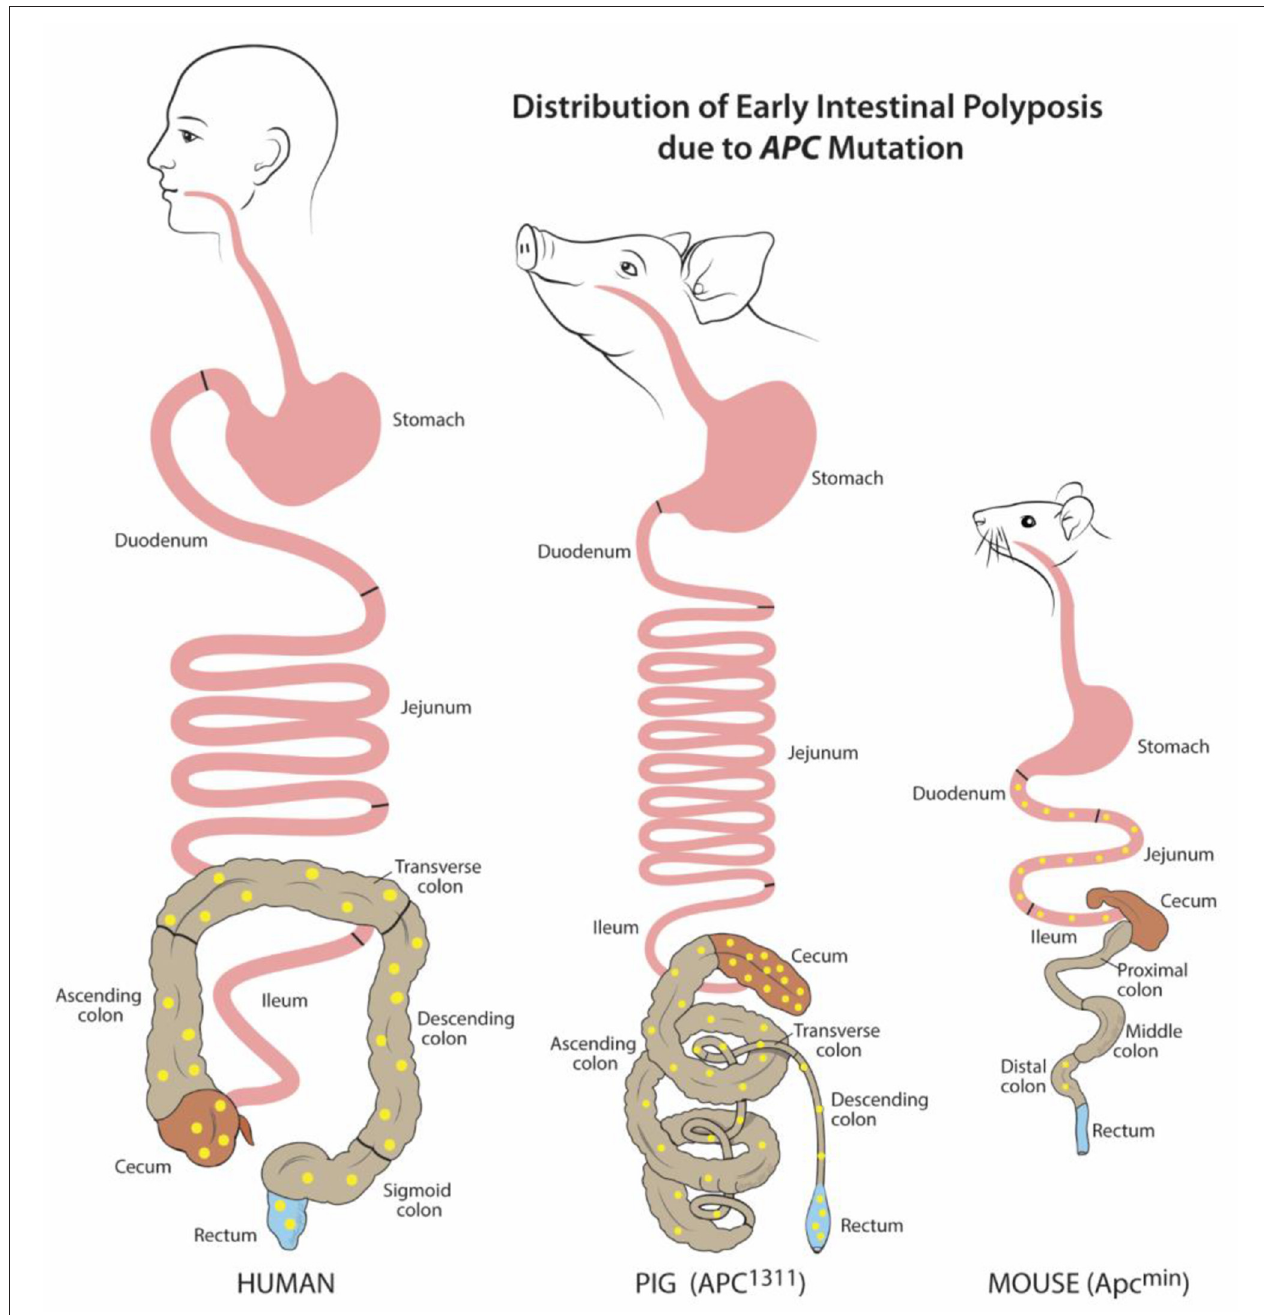
FIGURE 1 | Distribution of early intestinal polyposis due to APC mutation. Human and porcine ( APC 1311 ) early adenoma/polyp distribution is similar within the colon and rectum, while murine (Apc min ) is mostly localized to the small intestine. Adenoma/polyps shown in yellow. Figure adapted from Gonzalez et al. and Flisikowska et al. (21,